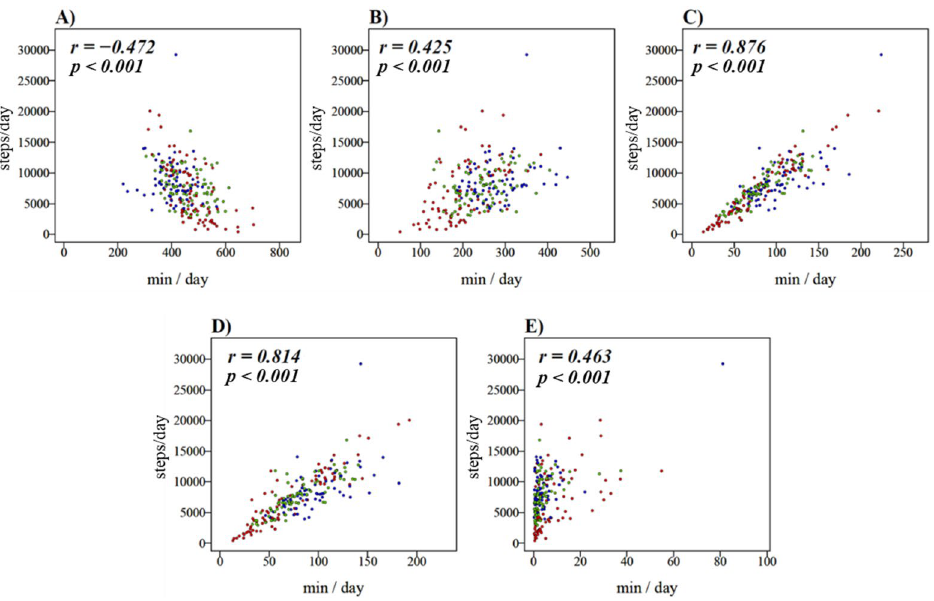
Figure 2. Scatterplots depicting the relationship between each type of physical activity and step counts of the total participants. (A) Sedentary behavior and step counts, ( B) light physical activity and step counts, ( C) moderate to vigorous physical activity and step counts, ( D) moderate physical activity and step counts, ( E) vigorous physical activity and step counts. (cid:1749) : Student group; (cid:1749) : Standing worker group; (cid:1749) : Sitting worker